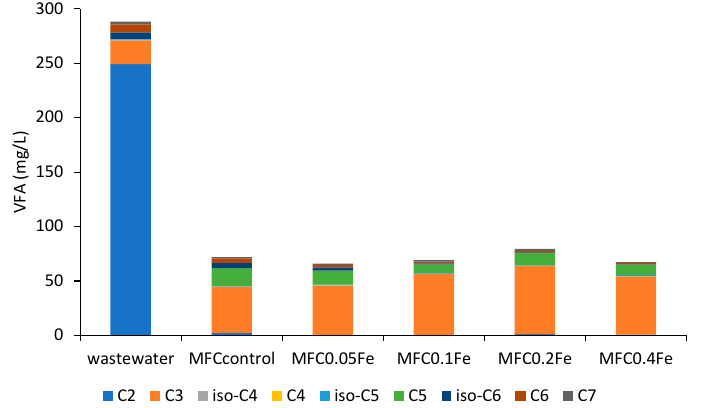
Figure 5. Profile of VFA concentration in raw wastewater and the effluents from all MFCs (average of n = 5), where C 2 —acetic acid, C 3 —propionic acid, C 4 —butyric acid, C 5 —valeric acid, C 6 —caproic acid, and C 7 —enanthic acid.